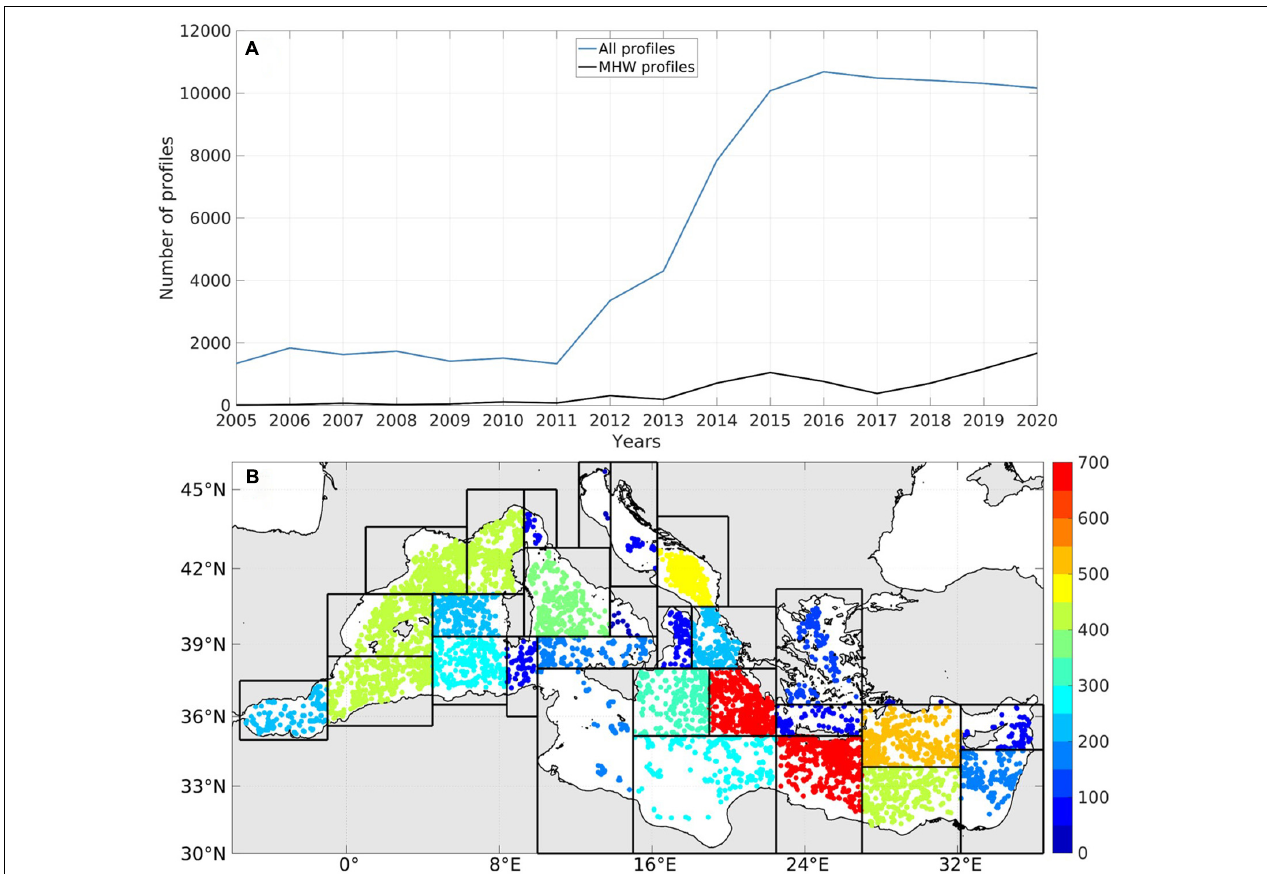
FIGURE 2 | (A) Annual number of hydrographic profiles from profiling floats available in the whole Mediterranean (blue line) and coinciding to MHW events (black line) from 2005 to 2020. (B) Locations of profiles coinciding with MHW over the period 2012–2020. The color indicated the sub-regional number of MHW profiles over